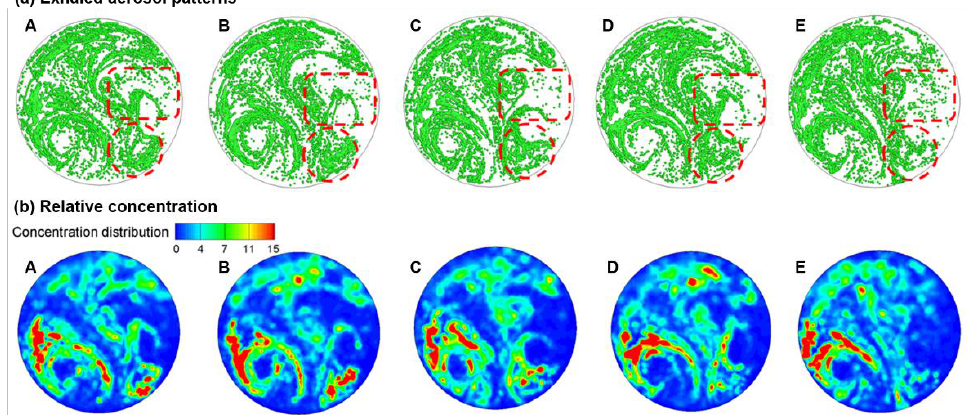
Figure 8. Test case 2: comparison of ( a ) exhaled aerosol patterns and ( b ) relative concentration among the five stages (A–E) of a growing squamous tumor.